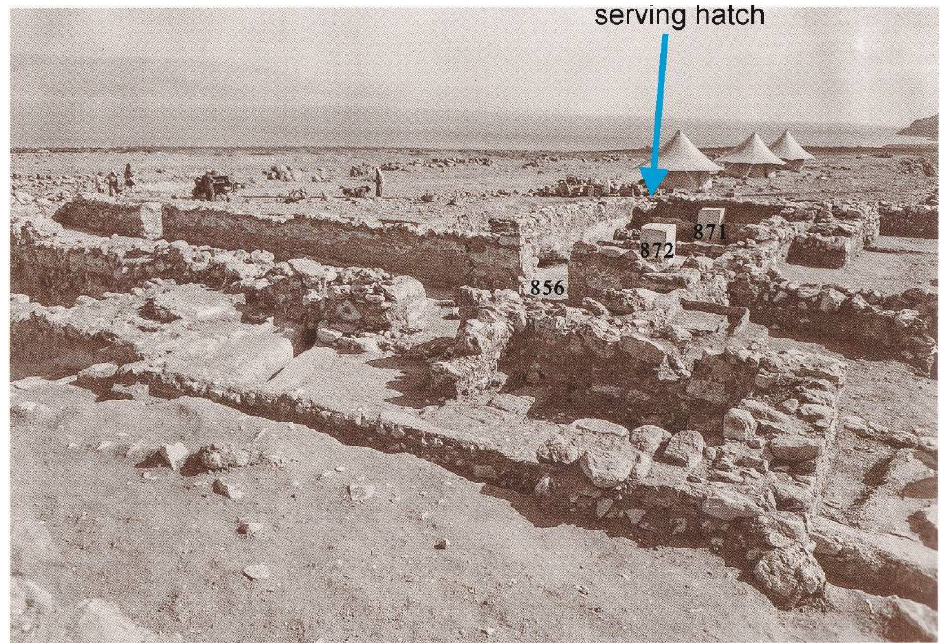
Figure 3. Rooms 77 and 86. Based on Humbert and Chambon